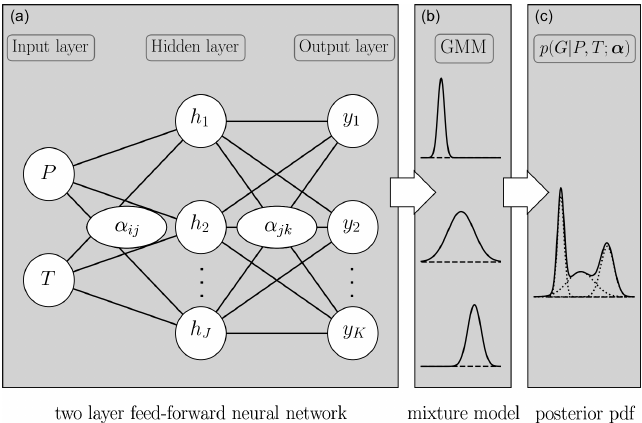
Figure C1. A mixture density network (figure modified after Bishop, 1994; Rijal et al., 2021) to approximate the (c) posterior probability density function for G at a given P and T (inputs). The posterior is approximated using a combination of (a) a conventional two-layer feed- forward neural network and (b) a Gaussian mixture model (GMM) that consists of Gaussian functions. α represents weights and biases of the feed-forward network. h j and y k represent hidden nodes and the outputs of the feed-forward network, respectively. The mean, standard deviation and weight of each Gaussian kernel are computed from y k . Then, a weighted sum of these Gaussians in the GMM approximates an arbitrary posterior probability density function.